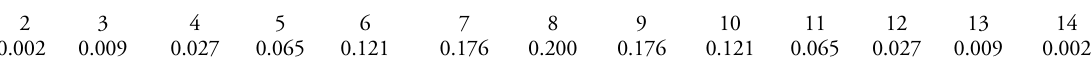
Probabilities for number of offspring per successfully breeding female surviving until winter